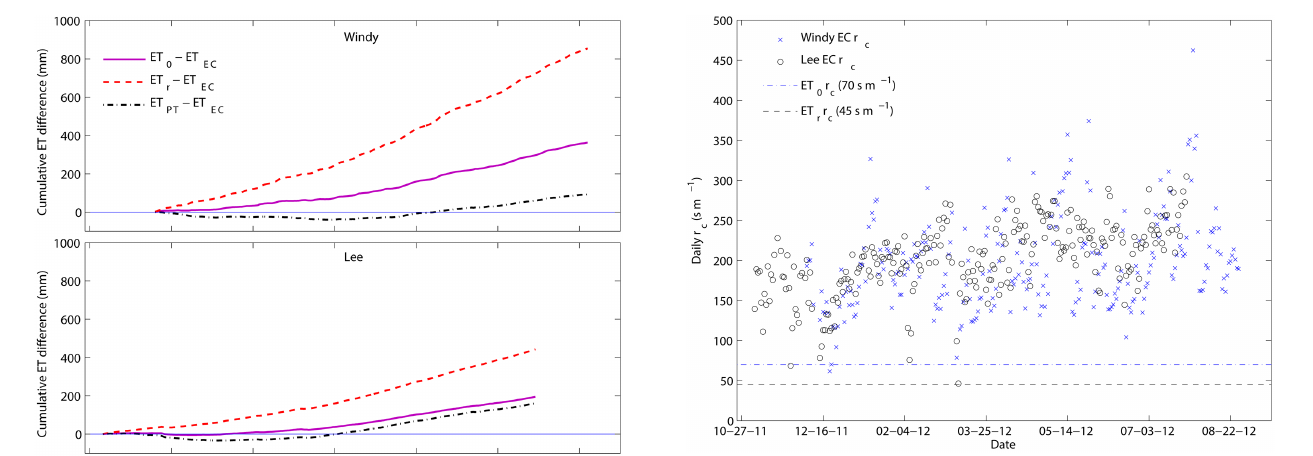
Figure 7. Calculated daily bulk canopy resistance at Windy and Lee from the EC towers for the mid-period. Dotted lines show daily time step resistances from short-canopy (ET 0 – 70sm − 1 ) and tall- canopy (ET r – 50sm − 1 ) reference surfaces.